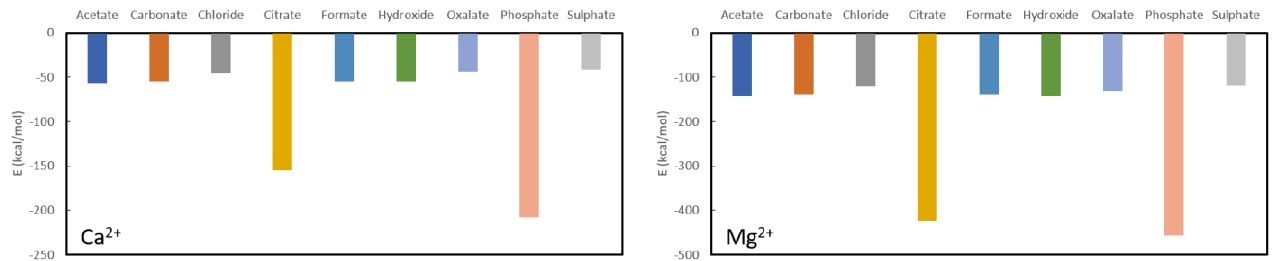
Figure 2. Formation energies for the complexes with Ca 2+ ( left ) and Mg 2+ ( right ).